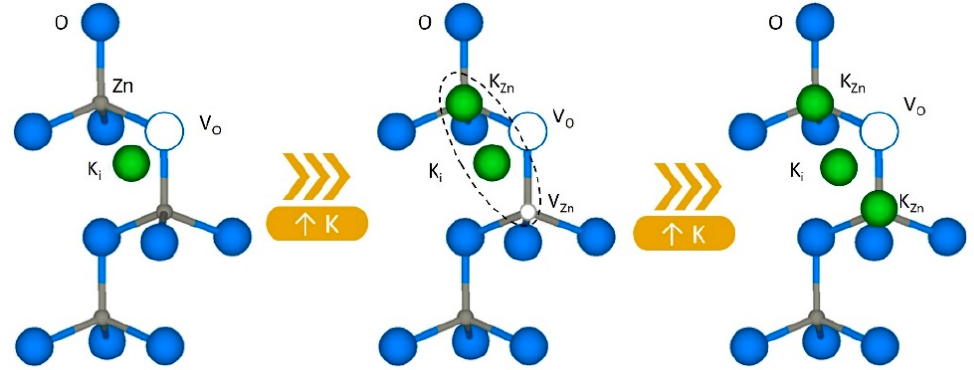
Figure 6. Schematic drawing of the changes occurred in the defect structure as a consequence of the incorporation of K + into the Zn lattice.